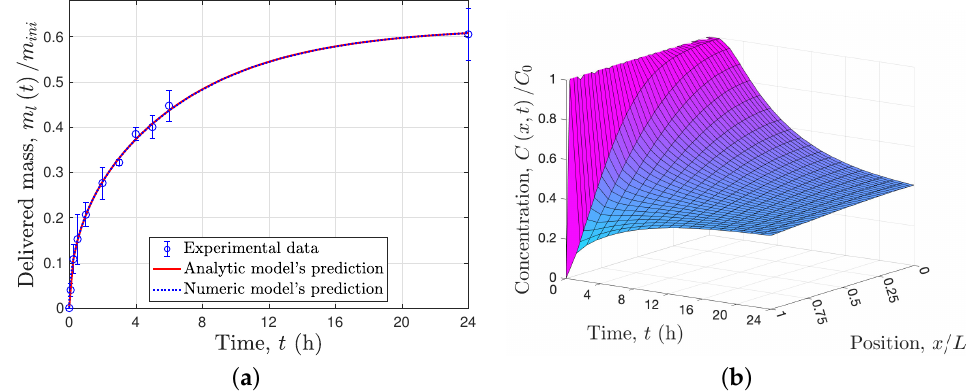
Figure 2. Single drug delivery. ( a ) Comparison of the experimental data and prediction for the delivered mass using Equation (32). ( b ) Prediction of the drug concentration profile in the solid matrix using Equation (31). The parameters are D / L 2 = 4.102 × 10 − 2 h − 1 , β = 6.095 × 10 − 2 , and Sh − 1 = 0.